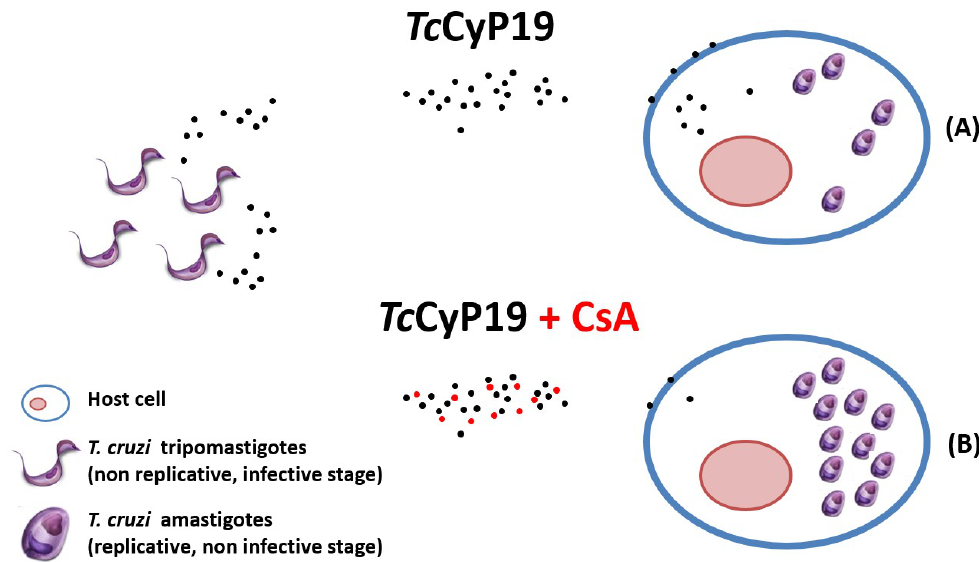
Figure 3. Tc CyP19 is abundantly expressed in T. cruzi , and interacts with mammalian cells, a process that was partially inhibited by Cyclosporin A (CsA). The pre-incubation of cyclophilin Tc CyP19 with VERO cells restrained the parasite penetration ( A ), and again, pre-incubation of Tc CyP19 with its inhibitor CsA or specific polyclonal antibodies recovered the percentage of parasite infected cells in control experiments ( B ). The inhibitory penetration effect of Tc CyP19 cyclophilin suggests a protective role of this protein to assure the survival of the infected tissue and allow parasite persistence.